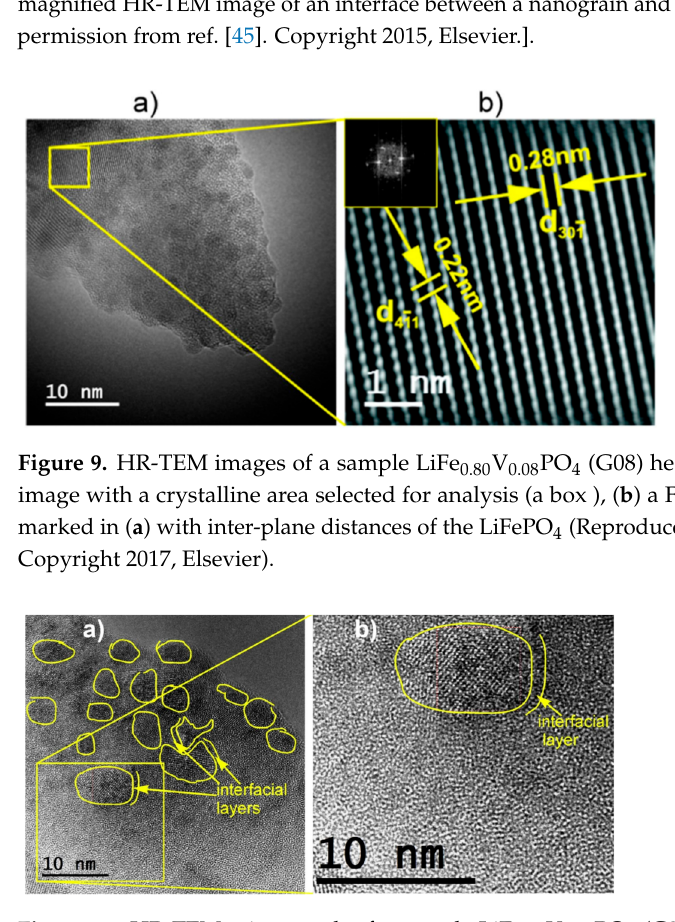
Figure 10. HR-TEM micrograph of a sample LiFe 0.5 V 0.20 PO 4 (G20) heat-treated up to 463 ◦ C (in argon): ( a ) marked are several “grains” with crystalline structure–most of the material remains amorphous; ( b ) a magnified fragment of the image ( a ) with a discernible ordered grains and a fragment of an intermediate interfacial layer around the grain (Reproduced with permission from ref. [48]. Copyright 2015,